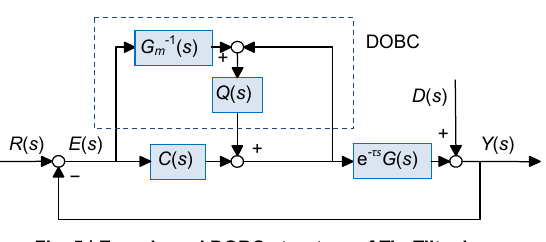
Fig. 5 | Error-based DOBC structure of Tip-Tilt mirror.